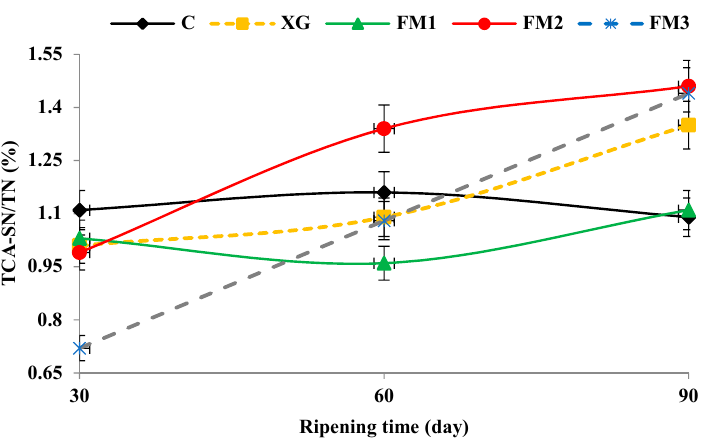
Figure 2. Changes in trichloroacetic acid 12%-soluble nitrogen as a percent of total nitrogen (TCA-SN/TN) of coated Cheddar cheeses during ripening. C, control, coated with polyvinyl acetate; XG, coated with 0.5% xanthan gum; FM1, FM2, and FM3 coated with 0.75%, 1%, and 1.25% flaxseed mucilage, respectively. Each dot represents the mean of the experimental data with an error bar of three replications.